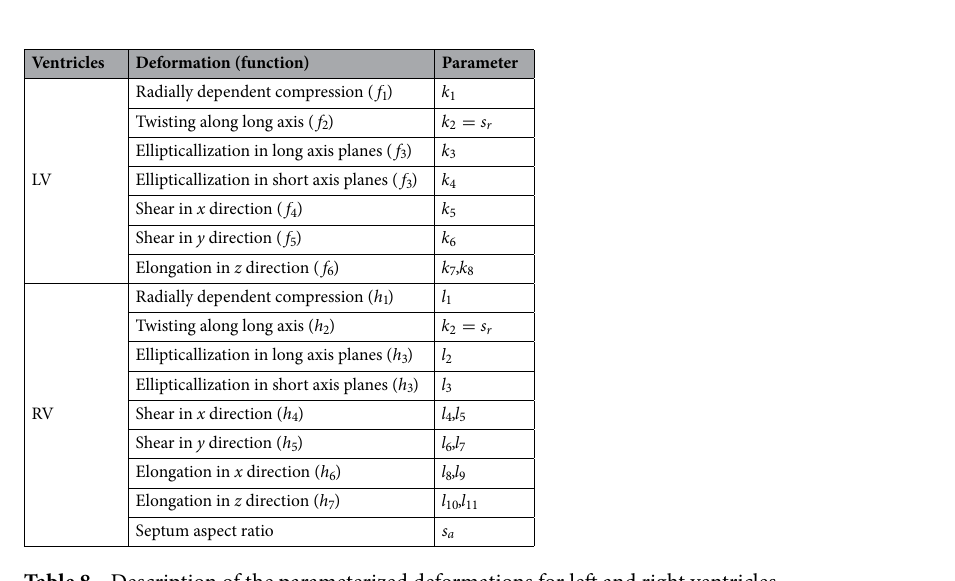
Table 8. Description of the parameterized deformations for left and right